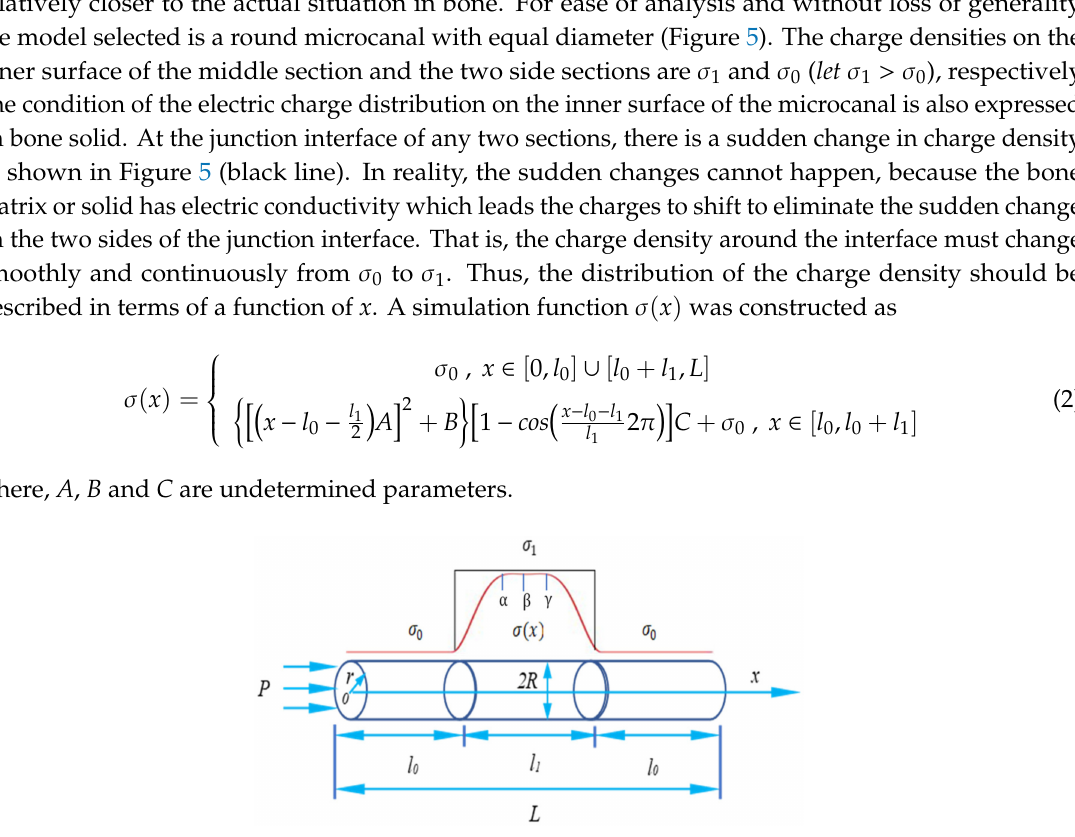
Figure 5. Geometric model with di ff erent electric charge density